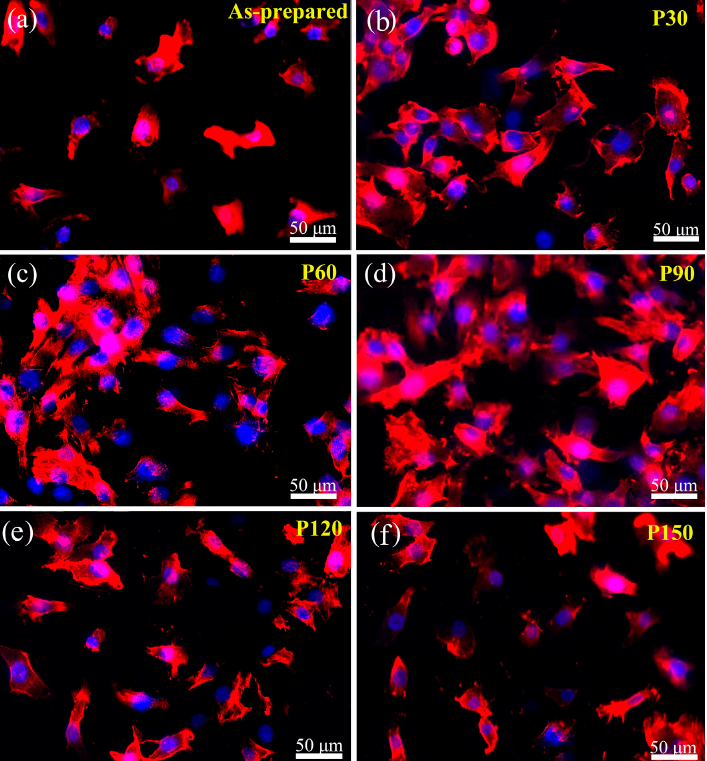
Figure 6. The immunofluorescence micrographs of osteoblast attachment on Ti samples after one-day of incubation. Rhodamine-phalloidin was used to stain the actin filaments and DAPI was utilized to stain cell nuclei. ( a ) Control sample without etching, ( b – f ) after etching for 30, 60, 90, 120, and 150 min, respectively [96] (reproduced with permission number: 5066331116663, John Wiley and Sons).